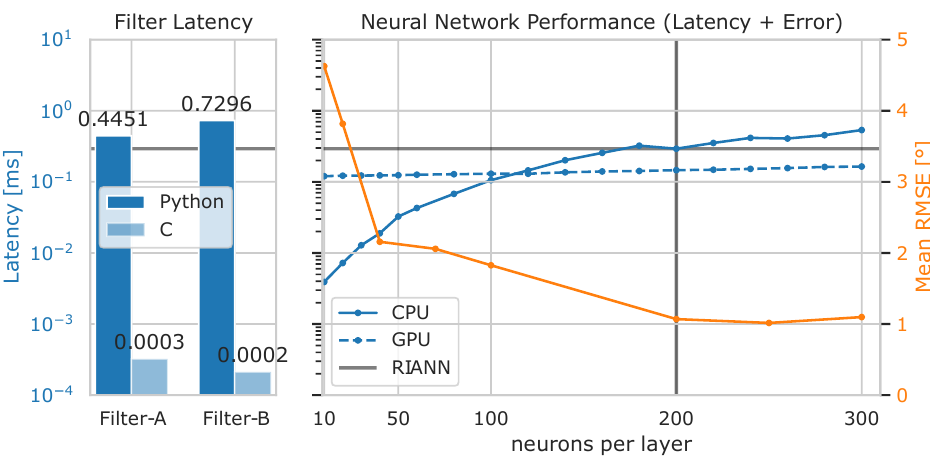
Figure 10. Inference latency and mean RMSE of different neural network sizes, compared to the latency of a C and native Python implementation of popular conventional filters. On both CPU and GPU, the network RIANN with 200 neurons per layer is slightly faster than the native Python